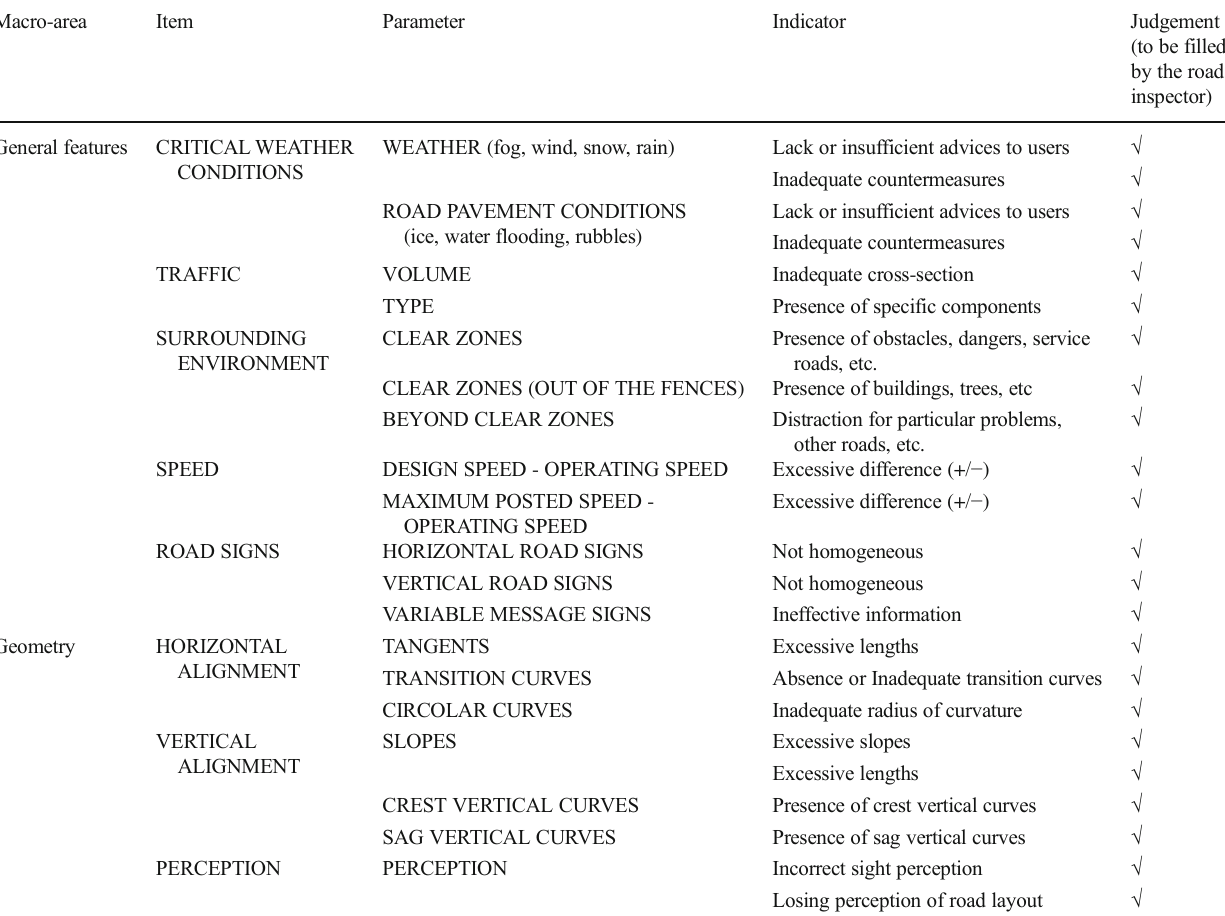
Part of a preliminary road inspection sheet (adapted from [25])